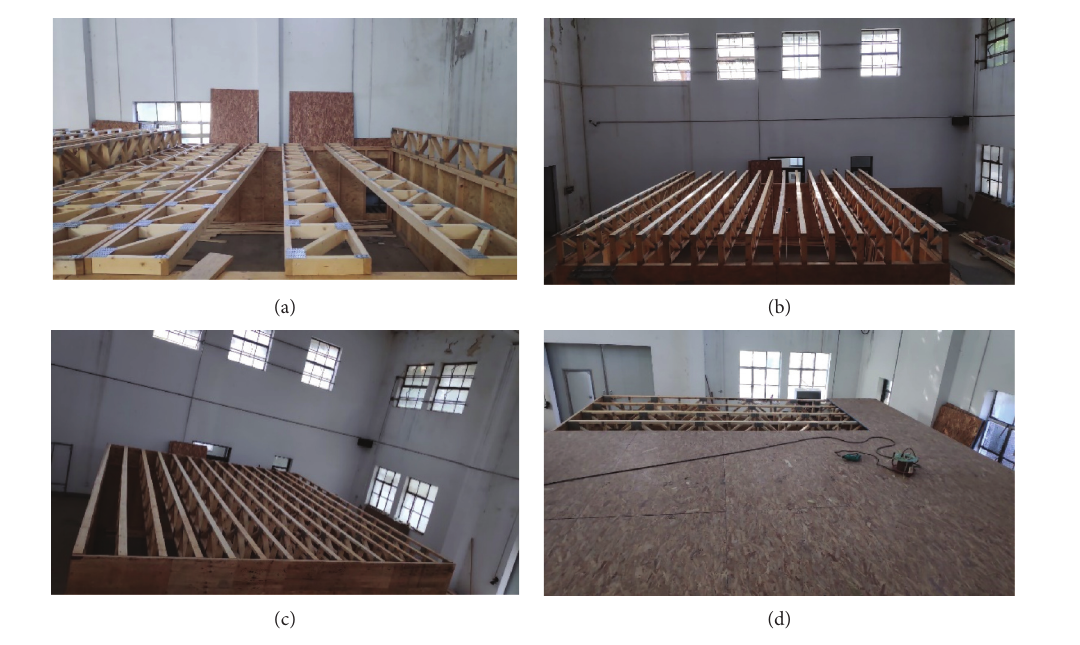
Figure 2: Construction process of the test